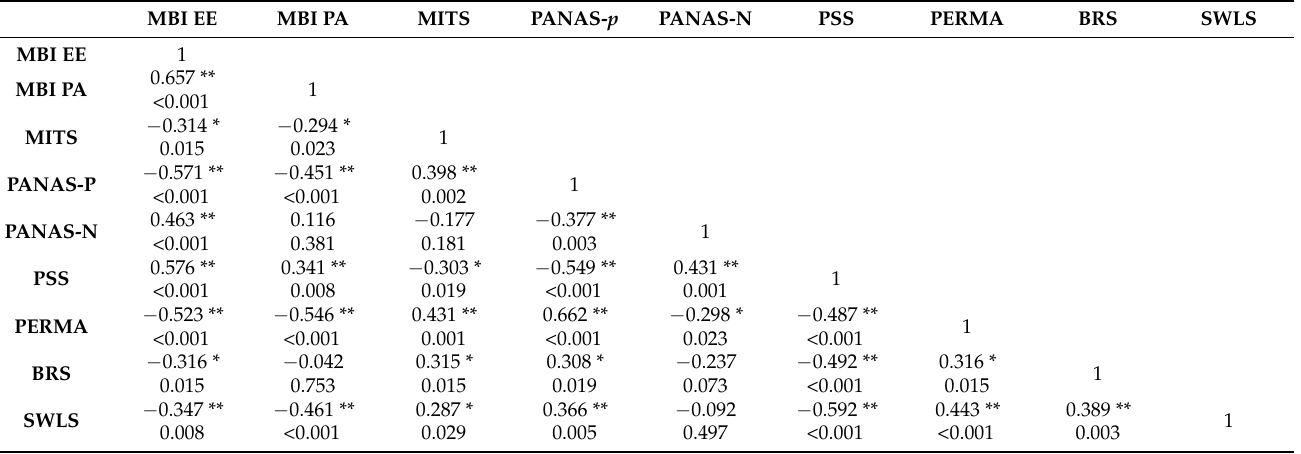
Table 3. Pearson correlation between measures at baseline (n =